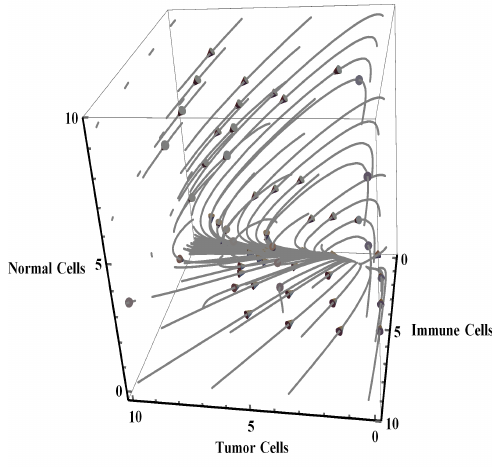
Figure 3. The behavior of solutions of the NTIUNHDM around the equilibrium